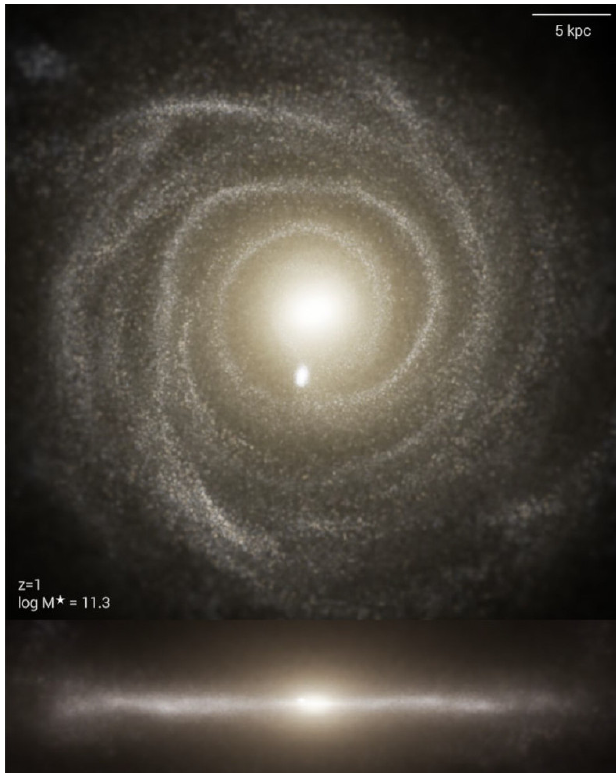
Fig. 101.— Details of a massive disk galaxy at redshift z = 1, simulated with the TNG50 simulation. Image: TNG